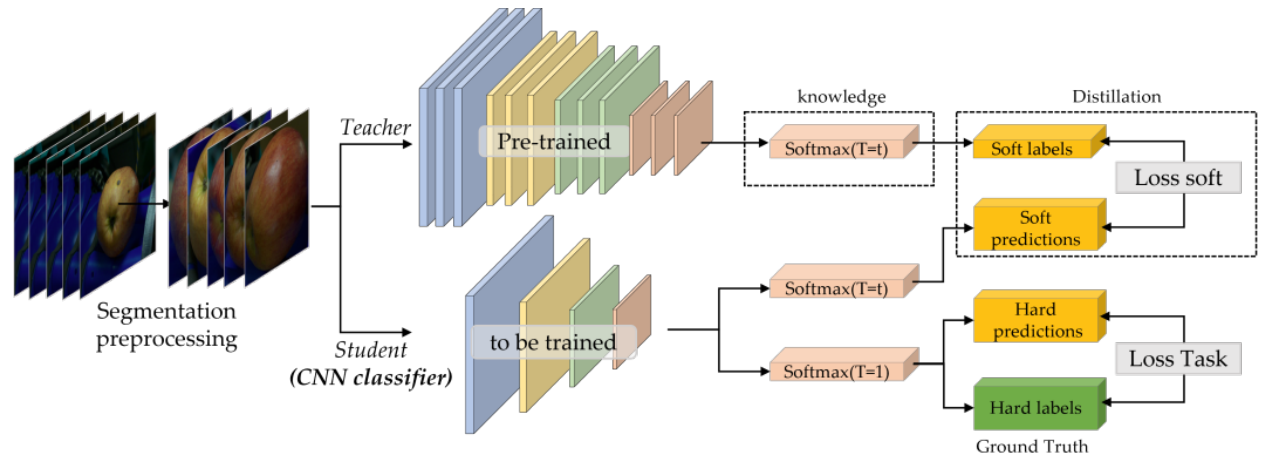
Figure 8. KD framework for CNN classifier.